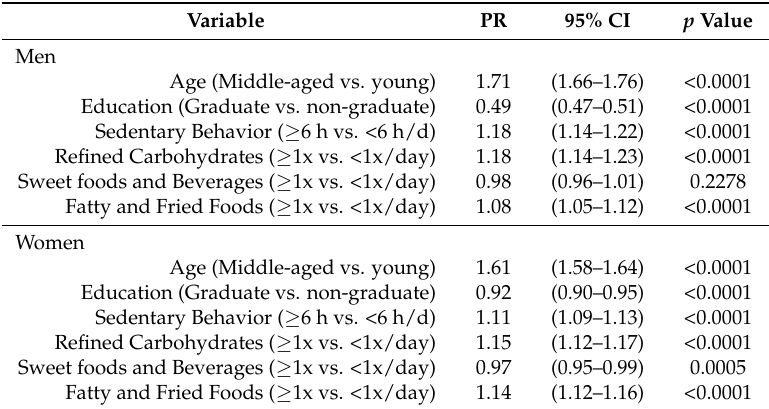
Table 2. Prevalence ratio (PR) of obesity by gender.